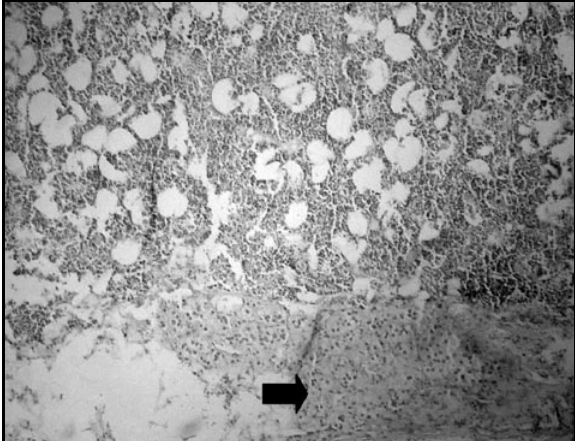
Figura 3 – Aspecto microscópico mostrando áreas de tecido adiposo entremeado com tecido mielóide comprimindo o tecido glandular adrenal (seta) (hematoxilina e eosina, 200x)